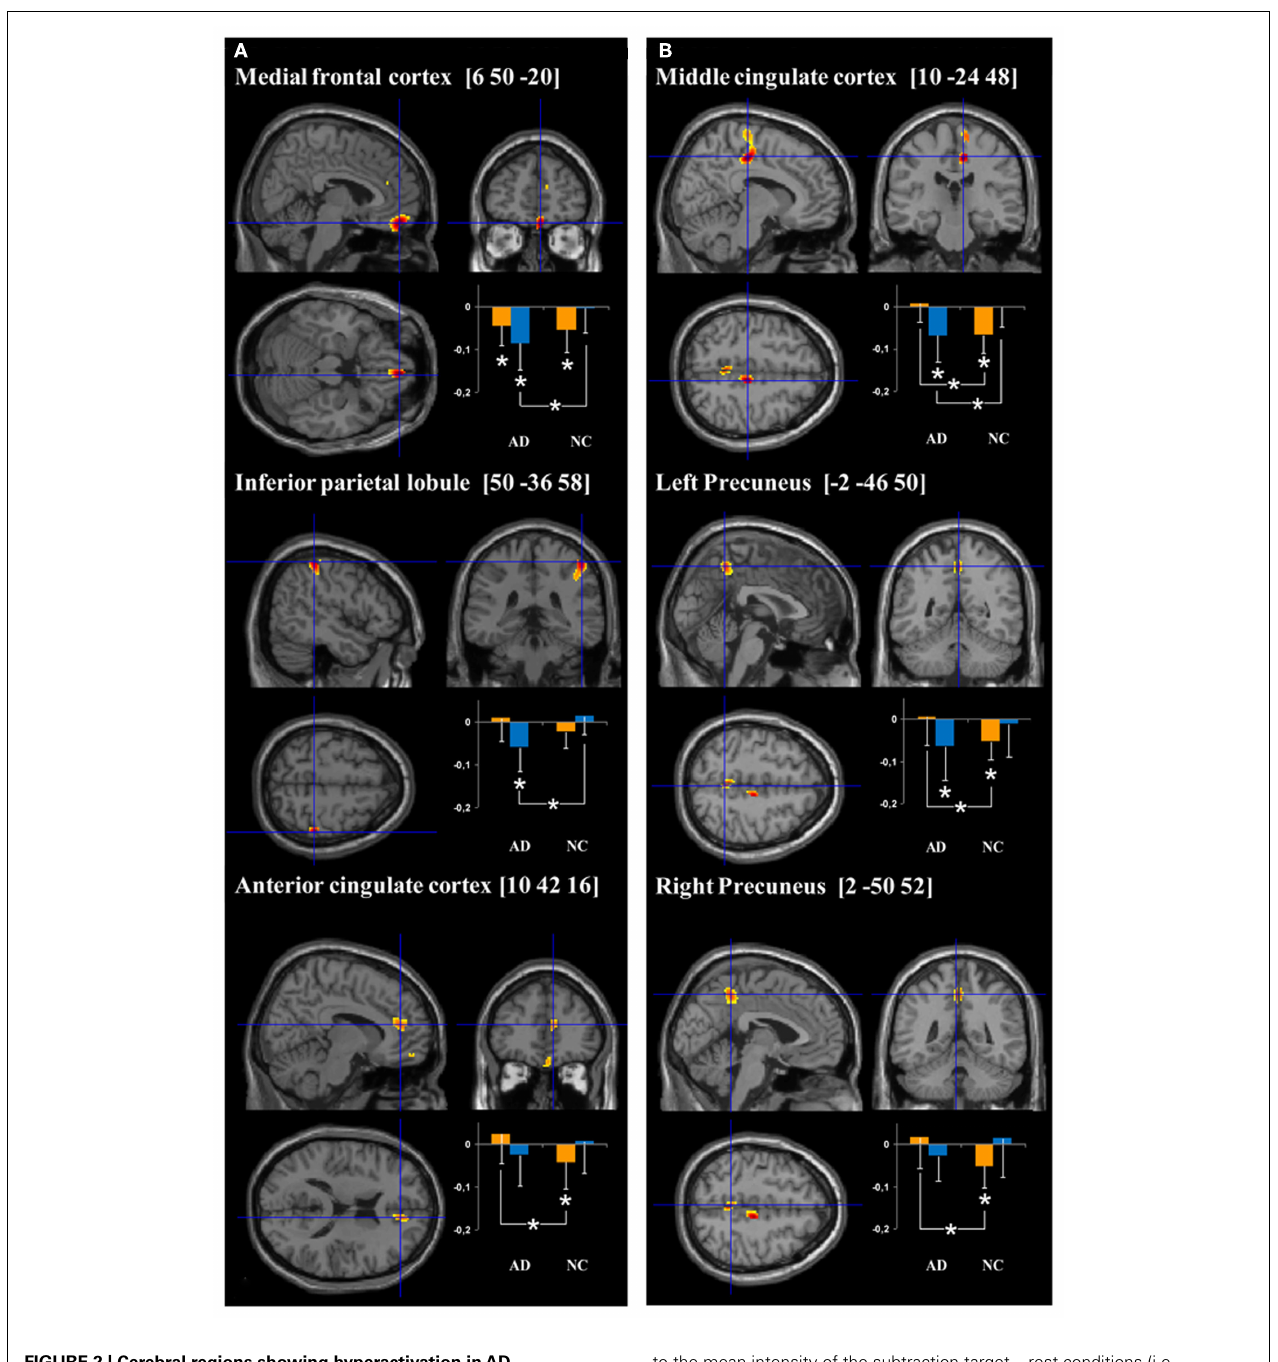
FIGURE 2 | Cerebral regions showing hyperactivation inAD patients compared to normal controls (NC) for (encoding – reading) and (stem-cued recall – stem-completion) contrasts (respectivelyA and B). Plots represent the signal change during target (orange bars) and control (blue bars) conditions relative to rest in AD and NC groups. More precisely, the orange bars correspond